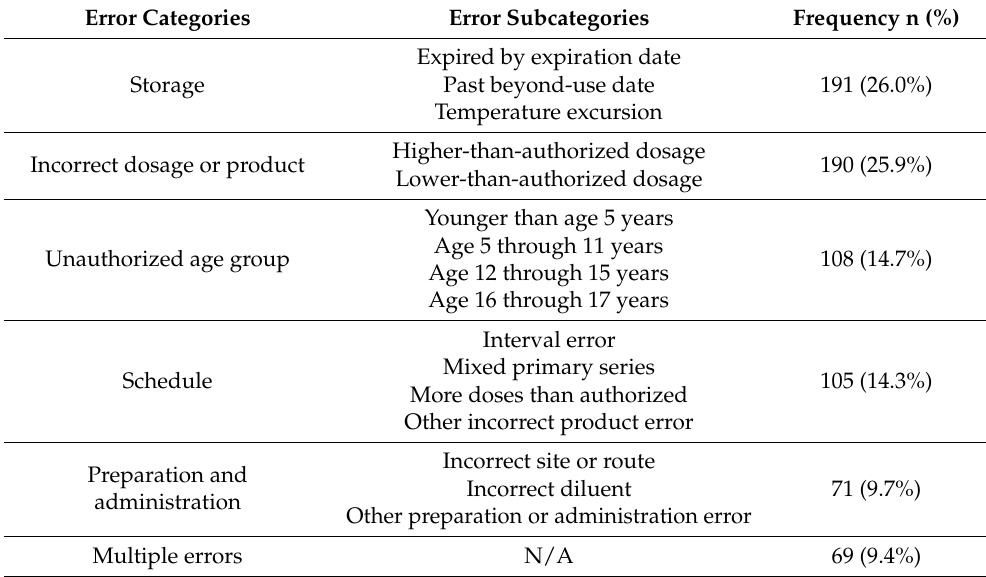
Table 2. Categories of COVID-19 vaccine administration